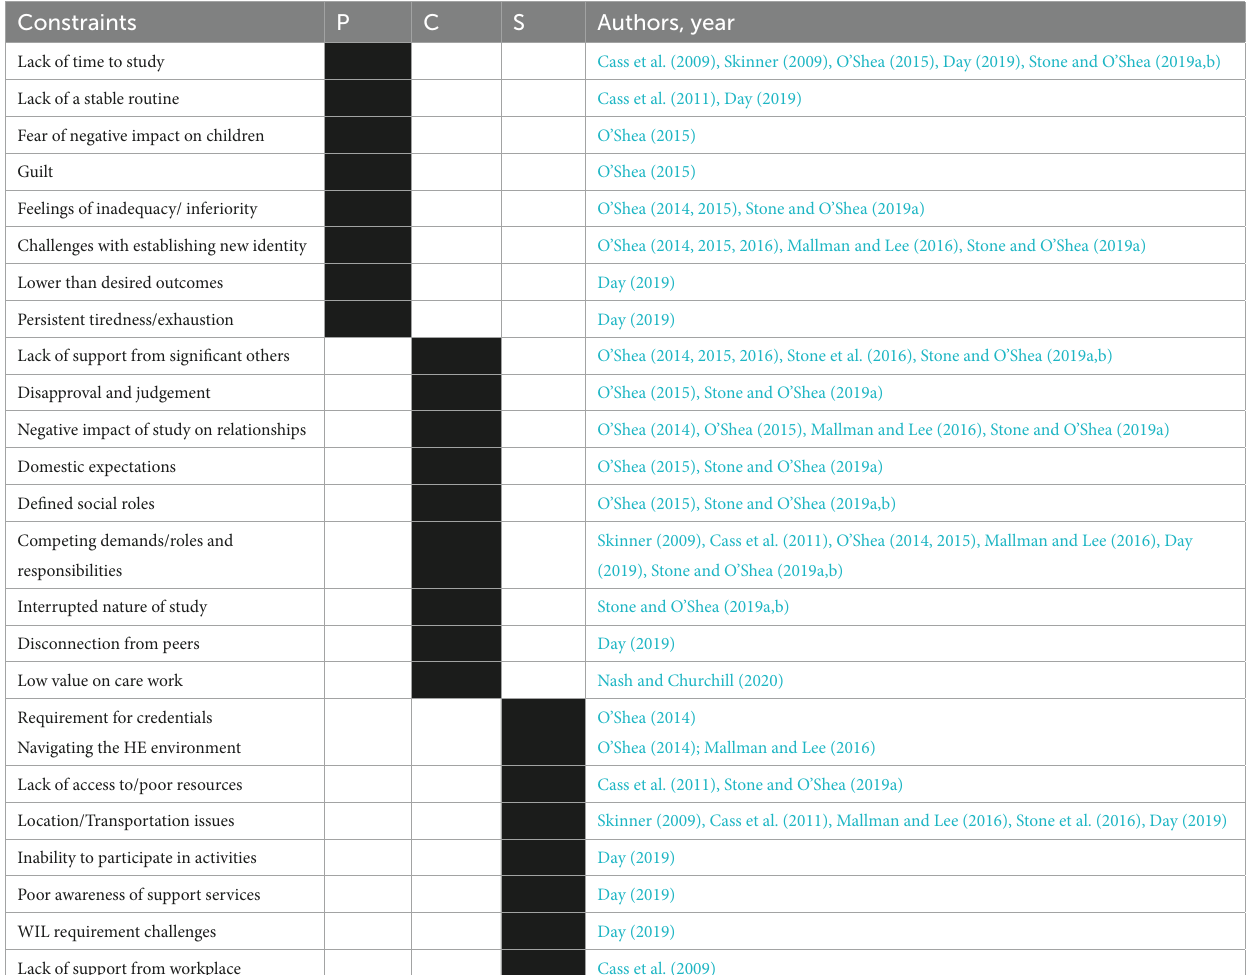
TABLE 5 Constraints indicated in